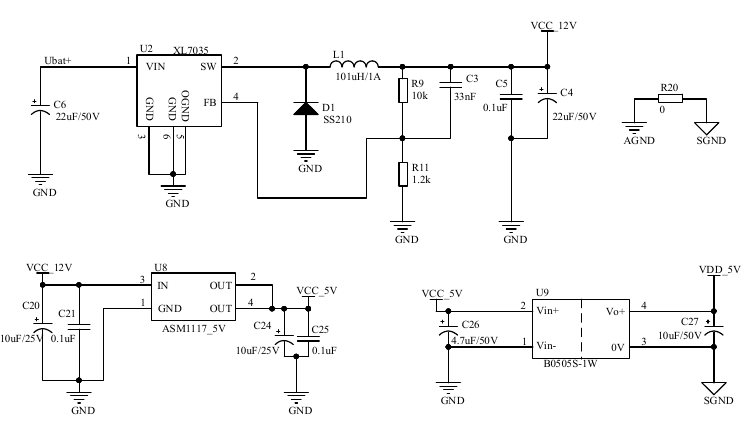
Figure 9. Auxiliary power circuit.